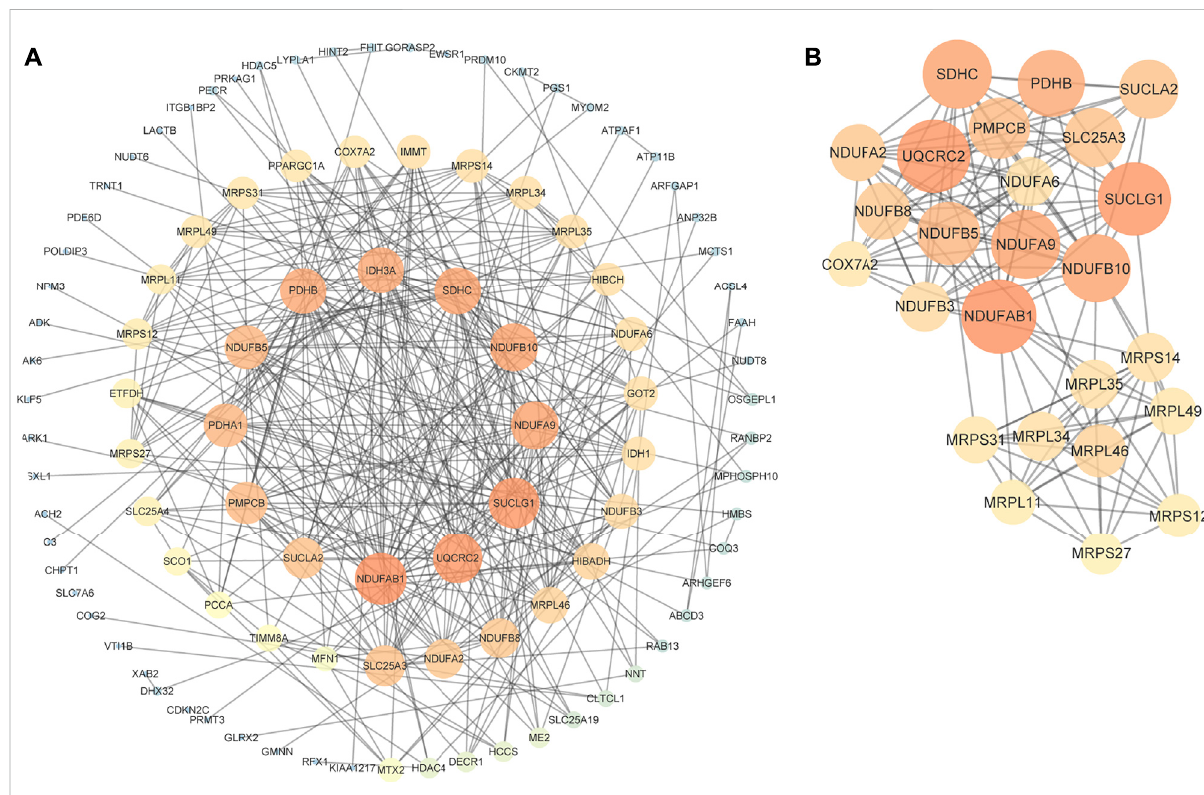
FIGURE 3 PPI network of negatively-regulating hub genes. (A) The core PPI network with a medium con fi dence score. (B) A signi fi cant module screened by MCODE. Different colors and sizes of nodes represent different degrees. The larger and brighter the node becomes, the greater the degree